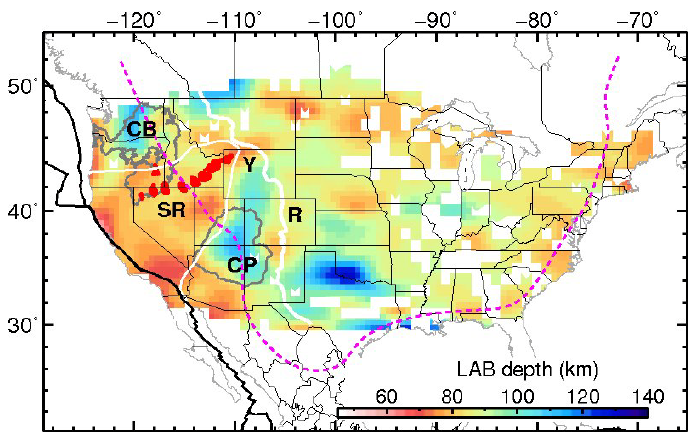
Fig. 20. Map of receiver function LAB. The dashed line marks the region with an approximately 200km-thick lithosphere obtained from surface wave studies (Yuan and Romanowicz, 2010). Key: see Fig. 1.